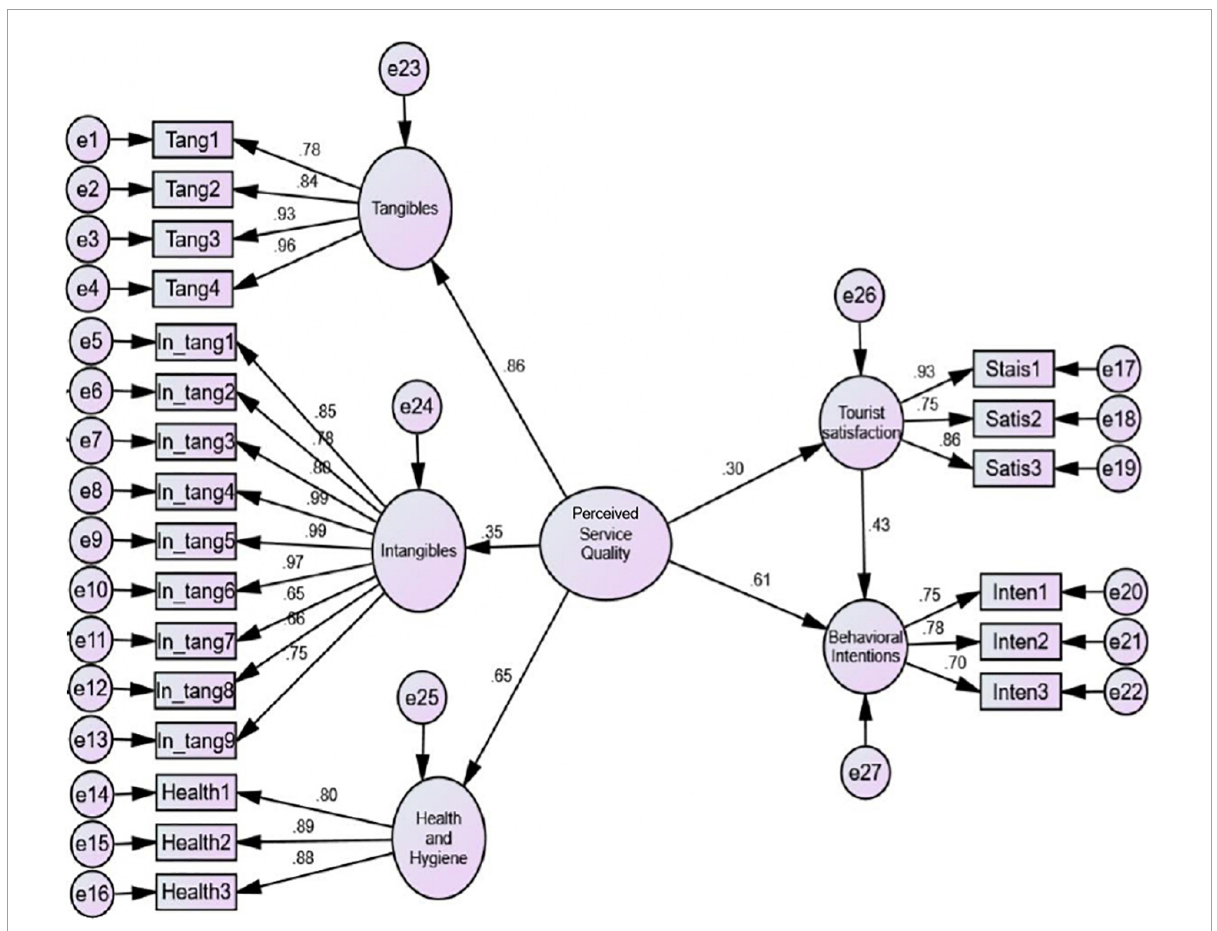
FIGURE2 The structural